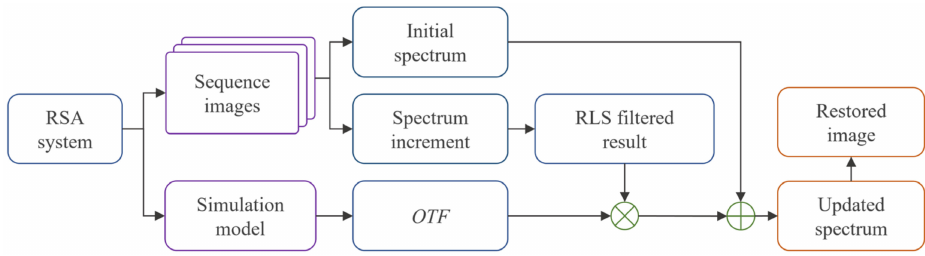
Figure 6. Flow chart of the proposed Fourier spectrum restoration algorithm.